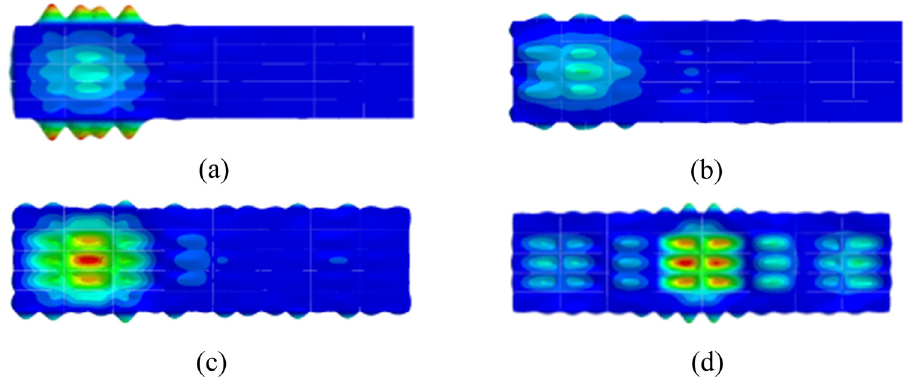
Figure 8: Modal results of multi - compartment truss ( setting struts ) : ( a ) 46.7 Hz, ( b ) 55.5 Hz, ( c ) 64.7 Hz, and ( d ) 82.7 Hz.